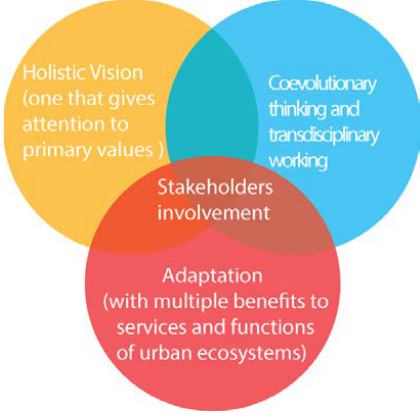
Figure 1. Planning for resilience—a conceptual framework (adopted from [16]).